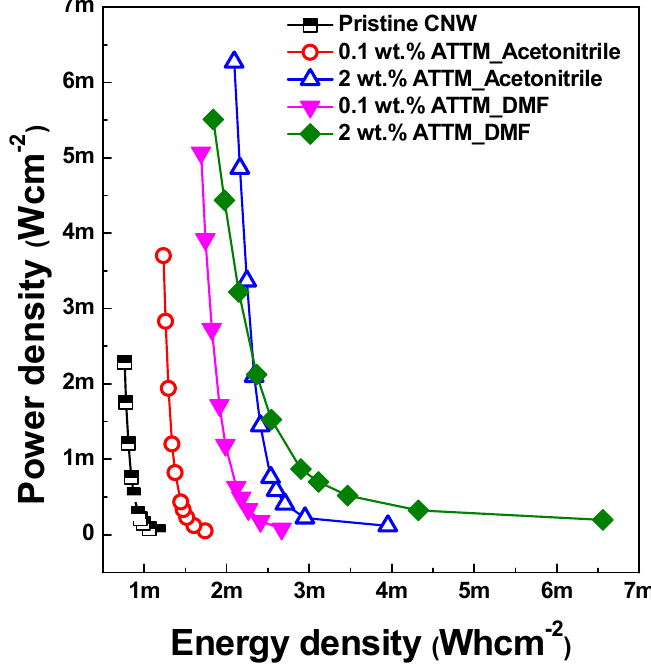
Figure 5. Ragone plot of the MoS2–CNW hybrid electrode.